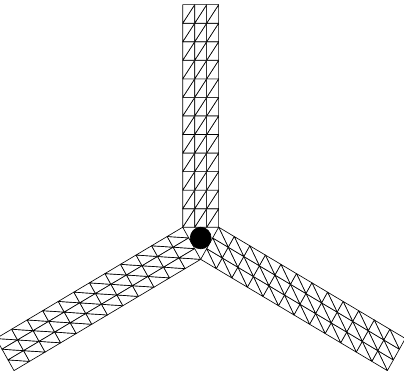
Figure 17. PO facet model of a simulated three-blade rotor.